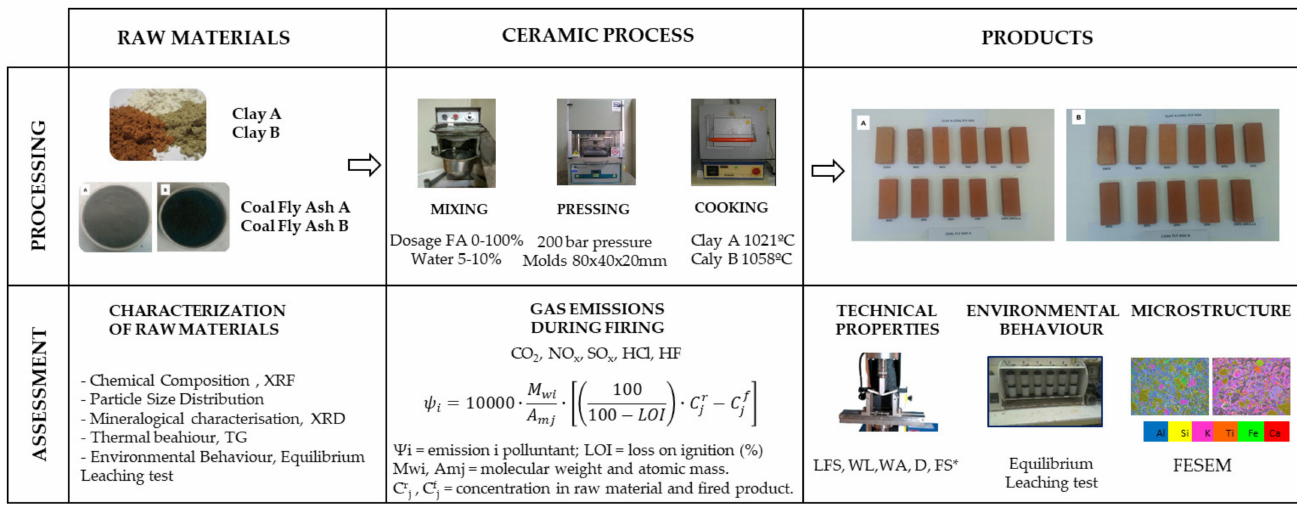
Figure 1. Methodology carried out in the development of this